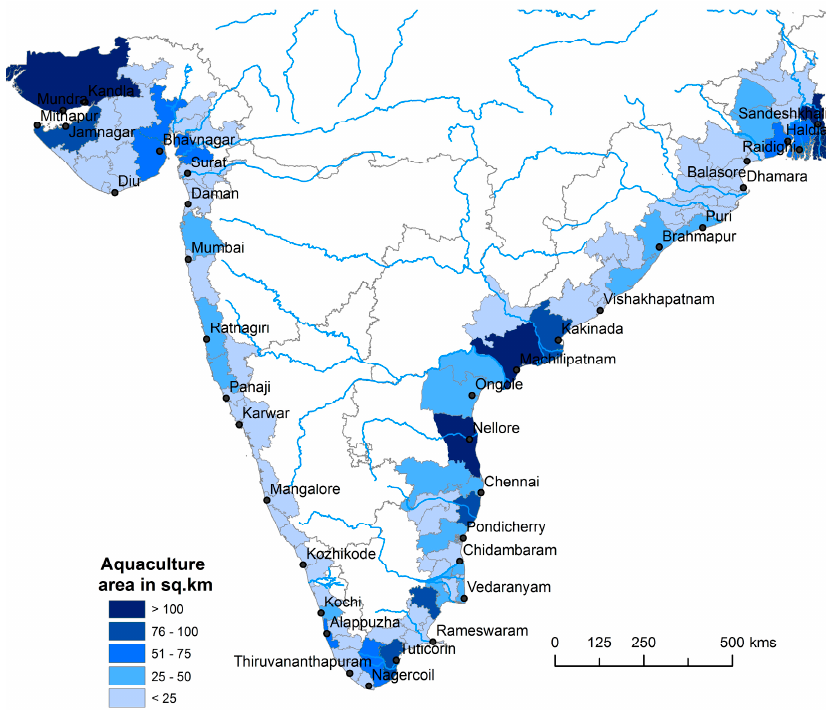
Figure 8. District-wise spatial distribution of aquaculture ponds along the districts on the Indian coast.